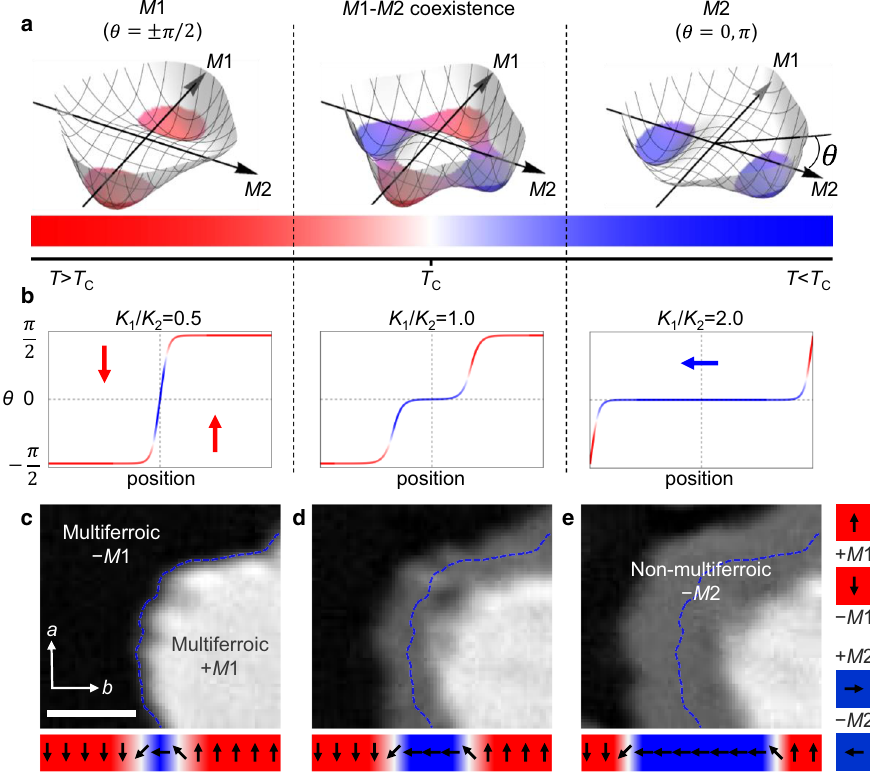
Fig. 1 Interconversion of domains and domain walls. a Temperature dependence of the free-energy landscape for the fi rst-order phase transition of Eq. (1) with θ as orientation of the order parameter. b Evolution of domains and domain walls across the M 1 ↔ M 2 phase transition. Domain walls expand into domains and domains are con fi ned into domain walls, with an intermediate regime where the M 1 and M 2 phases coexist. K 1 and K 2 are the magnetocrystalline anisotropy parameters of Eq. (1). Blue and red arrows depict the orientation θ of the order parameter. c – e Upon temperature decrease, a domain wall (dashed blue line) separating opposite multiferroic domains in c expands and transforms to a domain of the non-multiferroic phase in c and d . Faraday rotation (FR) by ϕ FR shows the M 1 domains as dark ( ϕ FR <0) and bright ( ϕ FR >0) regions and the M 2 domains ( ϕ FR = 0) as gray area. Scale bar, 100 μ